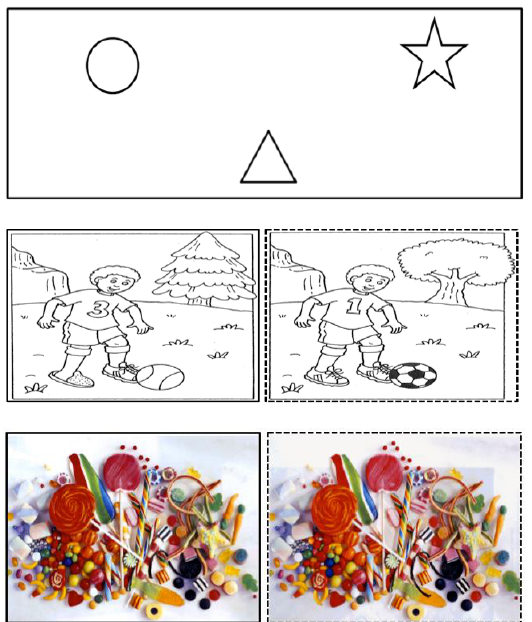
Figure 1. (Upmost) Example of the stimuli - ‘ free view ‘ condition, (middle) example of the stimuli - ‘ easy view ‘ condition, (below) example of the stimuli - ‘ hard view ‘ condition.